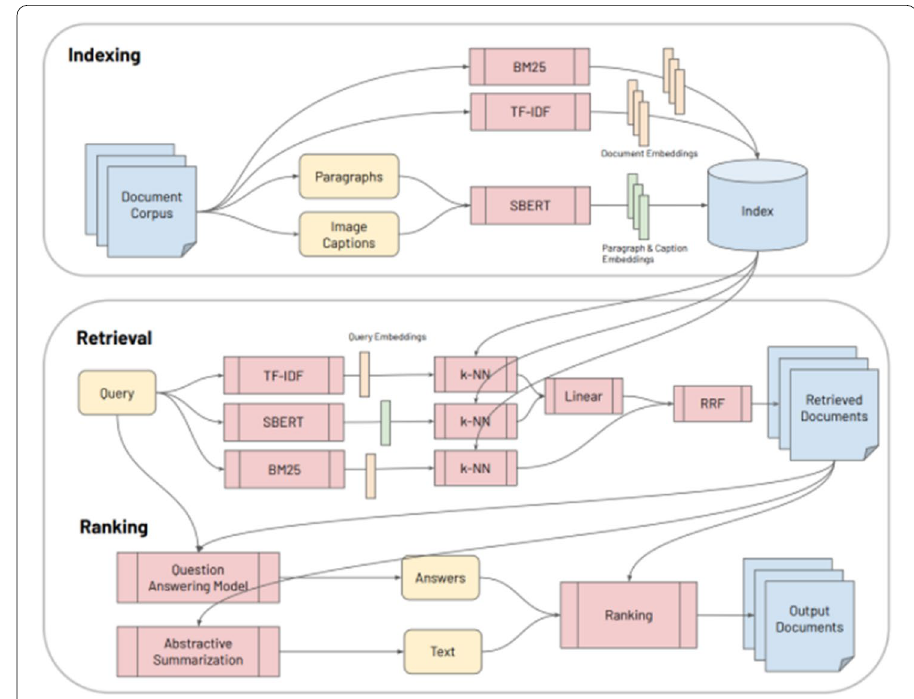
Fig. 4 CO-Search System Architecture (Image taken from Esteva et al.